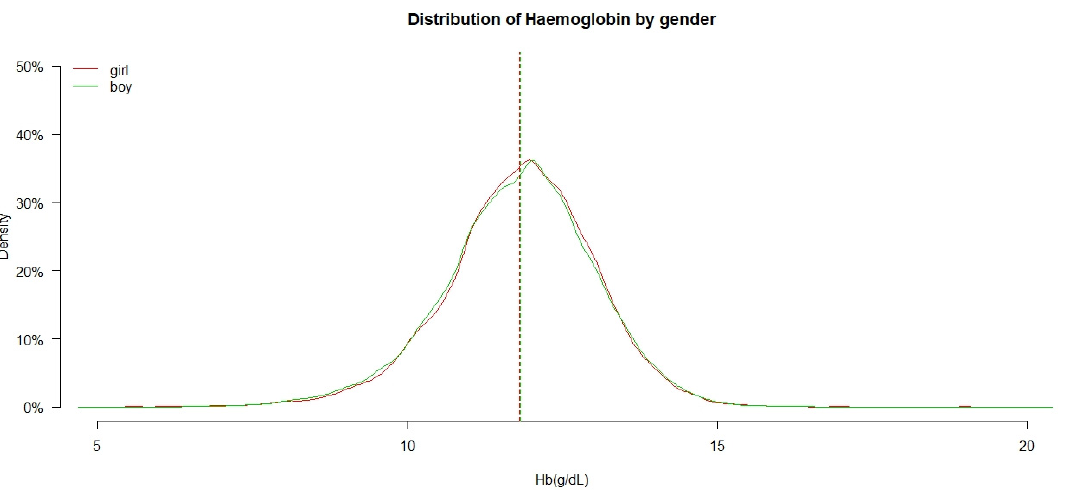
Figure 2. The distribution of haemoglobin (Hb) in boys and